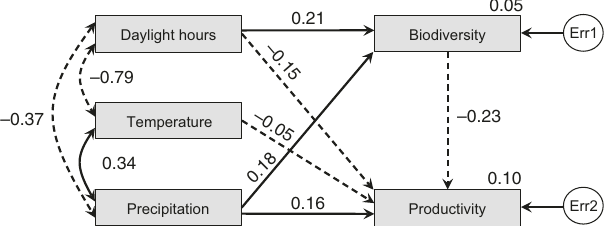
Fig. 2 Structural equation models showing the connections between biodiversity and productivity at the plot level ( N = 9640 plots). All retained arrows are signi fi cant ( P < 0.05). Solid and dashed one-way arrows represent positive and negative effects, respectively. Solid and dashed two- way arrows represent positive and negative correlations, respectively. Standardized regression weights (along one-way arrows), correlations (along two-way arrows) and squared multiple correlations (beside Biodiversity and Productivity boxes) for the fi tting model are shown. The exogenous unobserved variable err1 and err2 account for the unexplained errors in the estimation of biodiversity and productivity, respectively. Test statistic = 0.761, with 1 model degree of freedom and P = 0.383 (indicating close model-data fi t). Source data are provided as a Source Data fi le